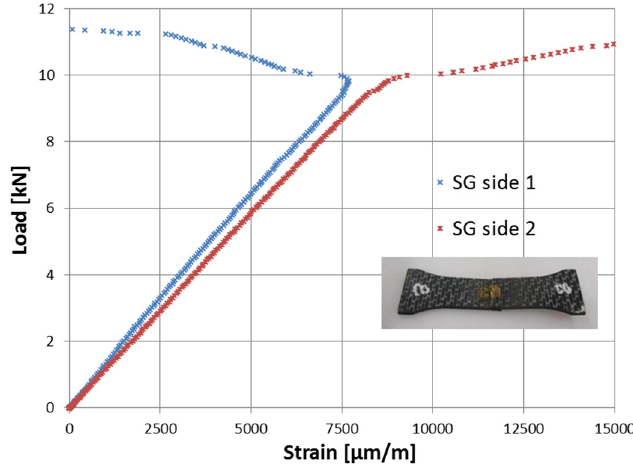
Figure 4. Compression test for warp-directional laminate: typical measured load vs longitudinal strain data and typical failure mode (SG: strain gauge).